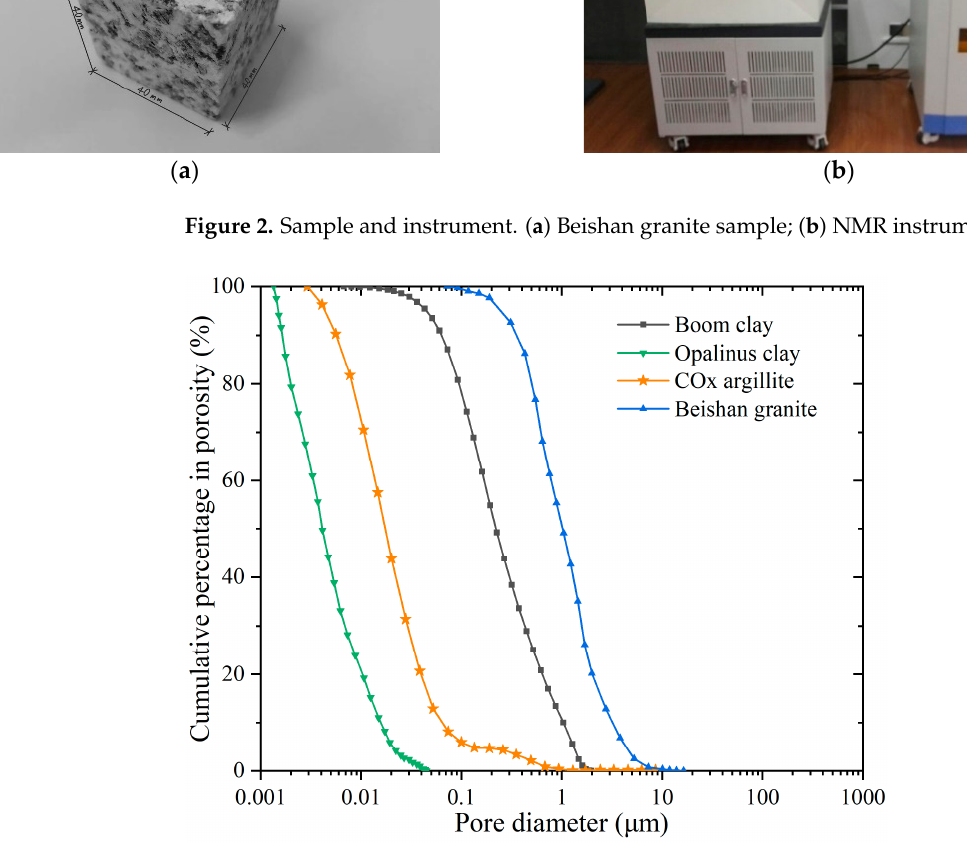
Figure 3. PSD curves of the studied rocks (Boom clay from [32], COx argillite from [34], Opalinus clay from [35]).